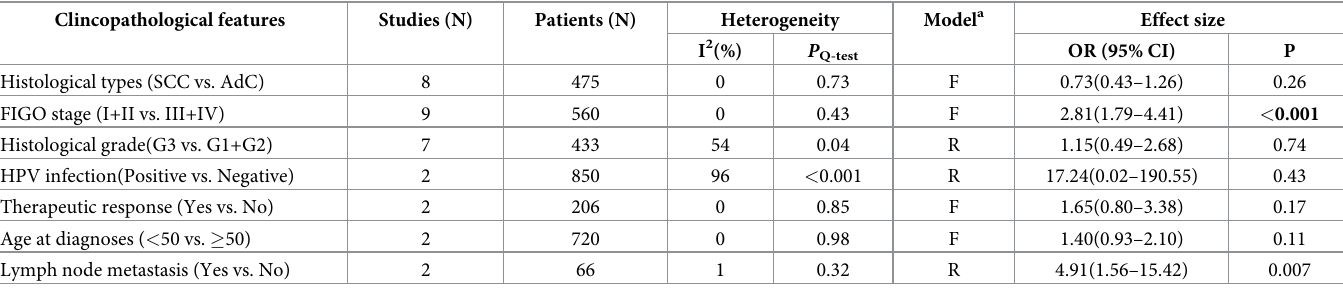
Table 6. Poole results for the associations between MGMT promoter hypermethylation and clincopathological features of CC. Clincopathological features